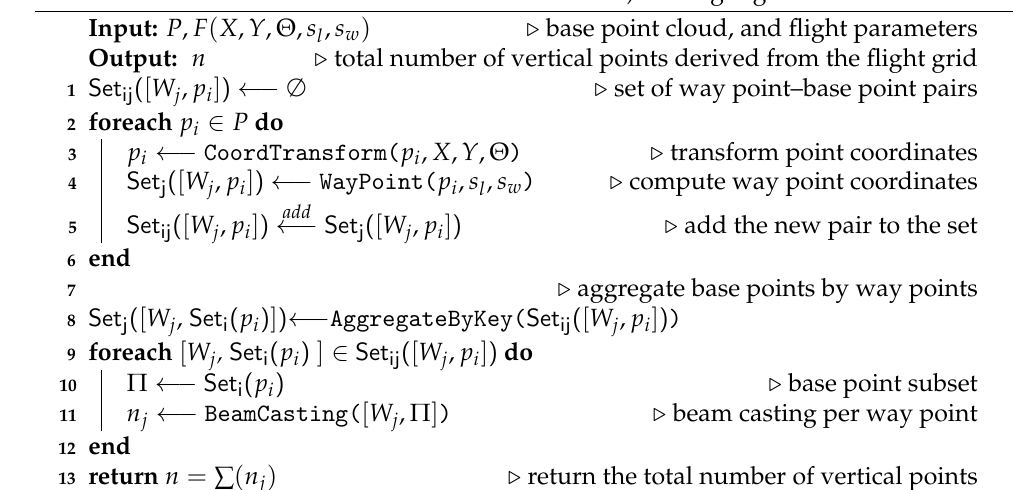
Algorithm 3 Parallel algorithm for computing the fitness score (i.e., the total number of laser beams incident on vertical surfaces) of a flight grid